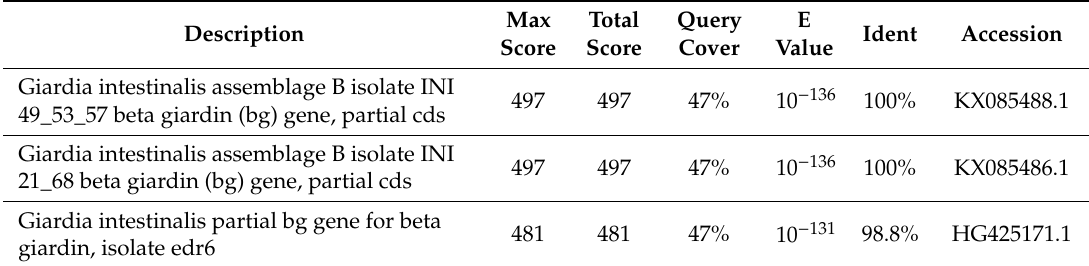
Table A1. BLASTn results for the sequences obtained by PCR amplification of the G. intestinalis β -giardin gene (Primer G376).